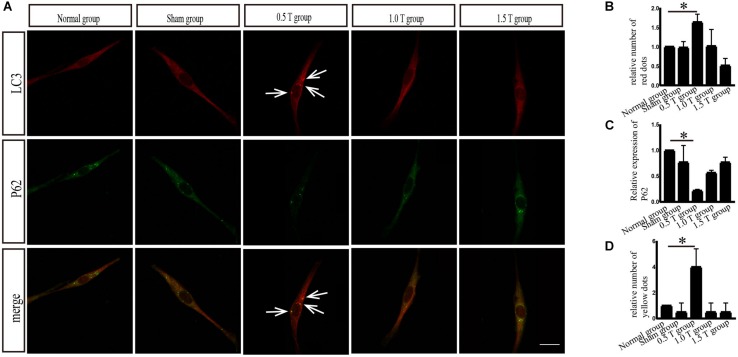
Immunofluorescence analysis of autophagy-related proteins. (A) Colocalization of LC3 with p62. Arrows showed positive regions. (B) Quantitative fluorescence intensity of LC3. (C) Quantitative fluorescence intensity of p62. (D) Colocalized puncta were quantified. Data were analyzed with a one-way ANOVA followed by Dunnett’s multiple comparison test. ∗P < 0.05. Scale bar, 20 μm. Error bars = SD. The values of LC3 and p62 in the 0.5 T group were 1.637 ± 0.206 and 0.218 ± 0.026, respectively. The values of colocalized puncta in the 0.5 T group were 4.000 ± 1.414.